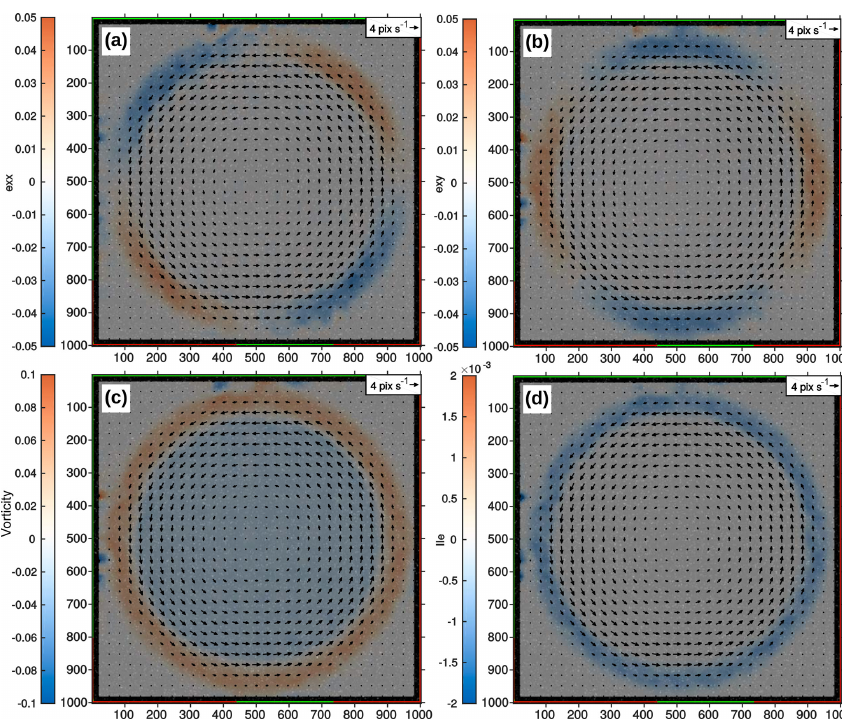
Figure 5. PIV results of the vortex synthetic test illustrating some of the scalar parameters that can be derived from the velocity field: (a) e xx ;